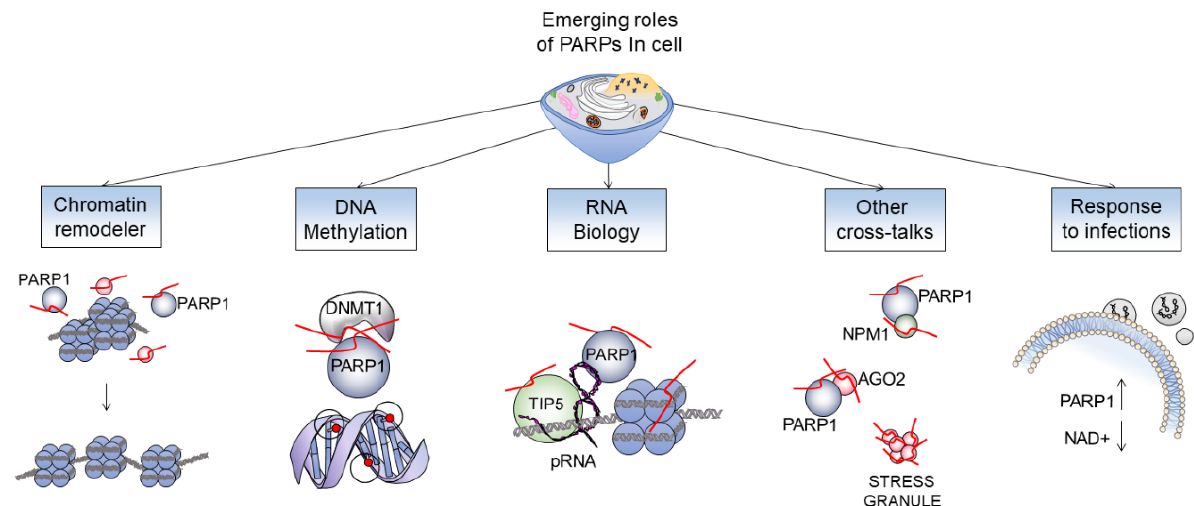
Figure 3. The wide range of functions carried out by PARP enzymes . Chromatin remodeling: PARylation determines conformational changes of the chromatin [3]; change in methylation profile: PARP1 neutralize DNMT1 activity [20]; RNA biology: the promoter RNA (pRNA) mediates association of TIP5 and PARP1 and activates the enzymatic activity of PARP1 to PARylate PARP1 itself, TIP5, or histones [21]; other cross-talks: depicted few examples of new emerging interactions of PARP1 with some nuclear proteins; response to infection: the consumption of NAD in cells is dramatically increased by the activation of PARP1 during infections (i.e., COVID 19) [22] .